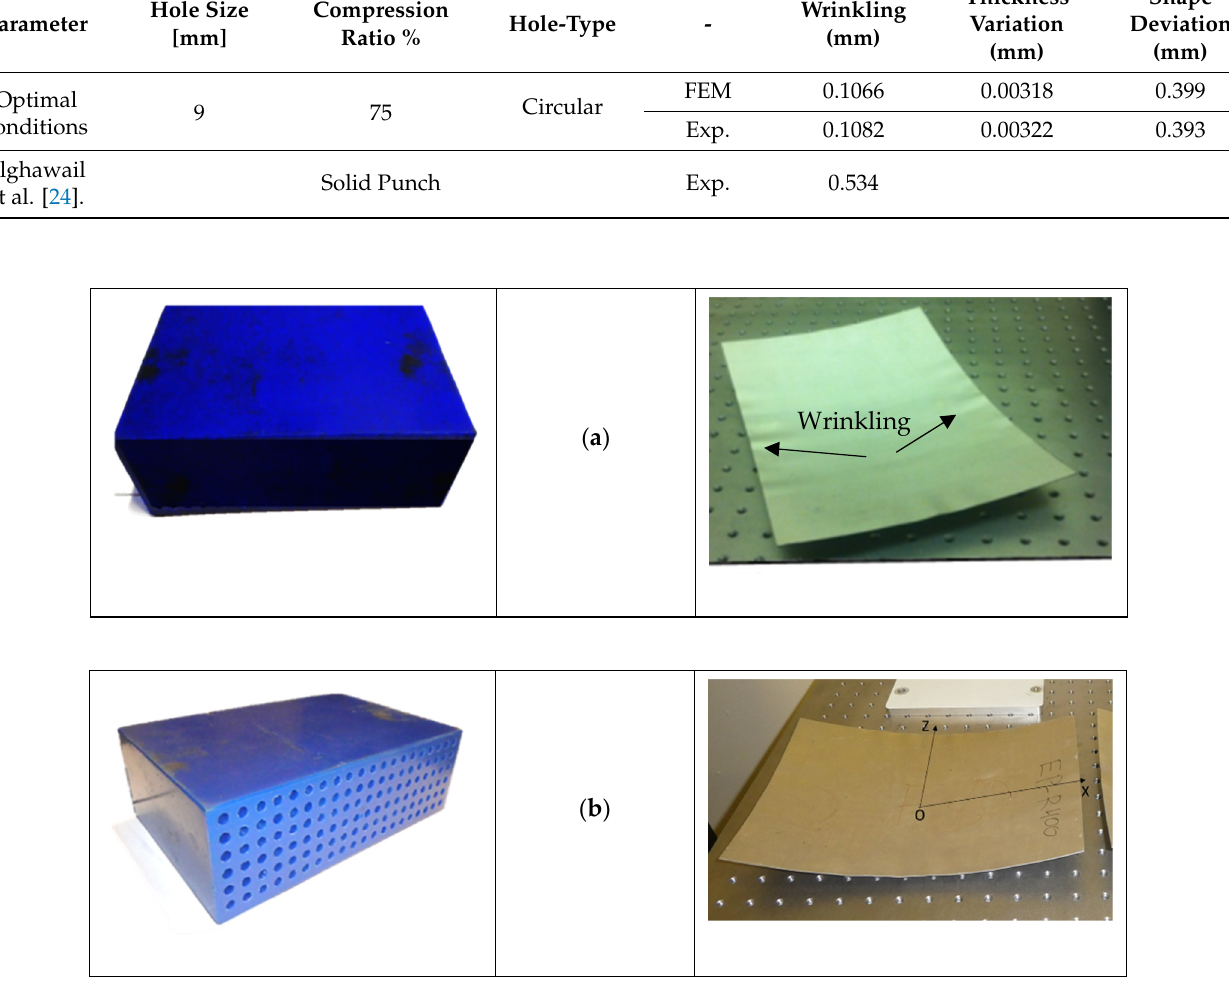
Figure 9. Parts produced used: ( a ) solid adapted from [29], and ( b ) Hole-type rubber punch MPIF configurations. ( a ) Solid rubber punch MPIF [24]. ( b ) Hole-type rubber punch